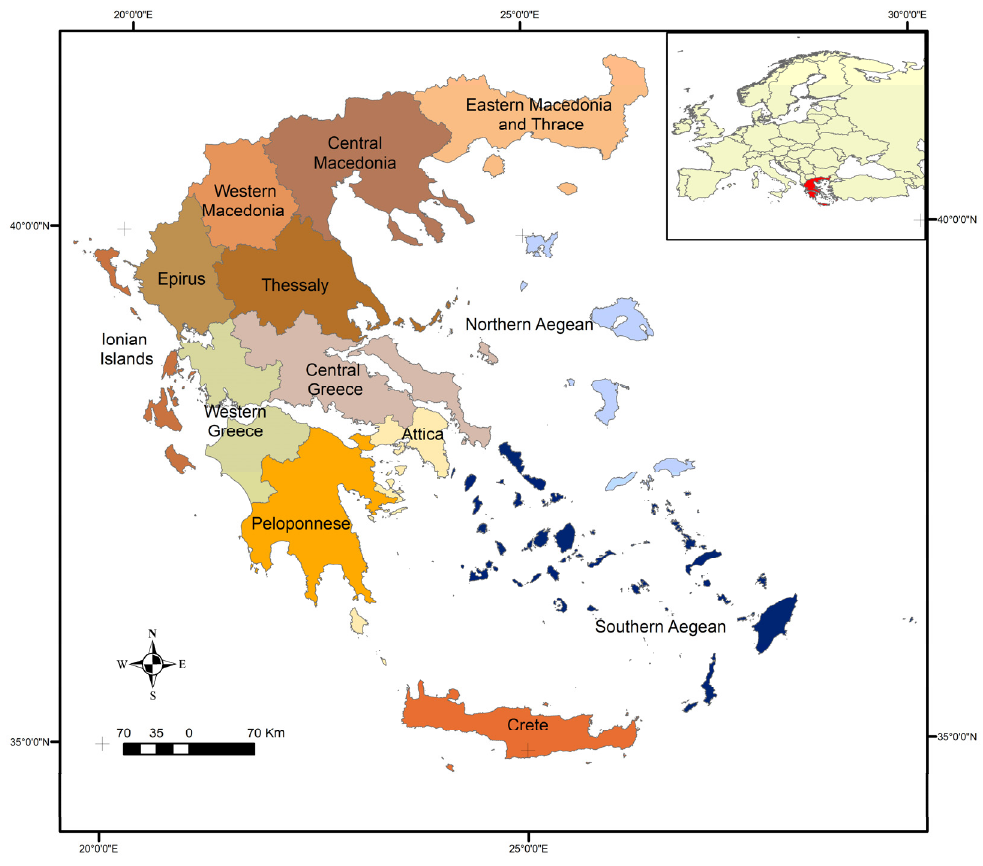
Figure 1. Map showing the 13 administrative regions of Greece, where the survey was carried out.